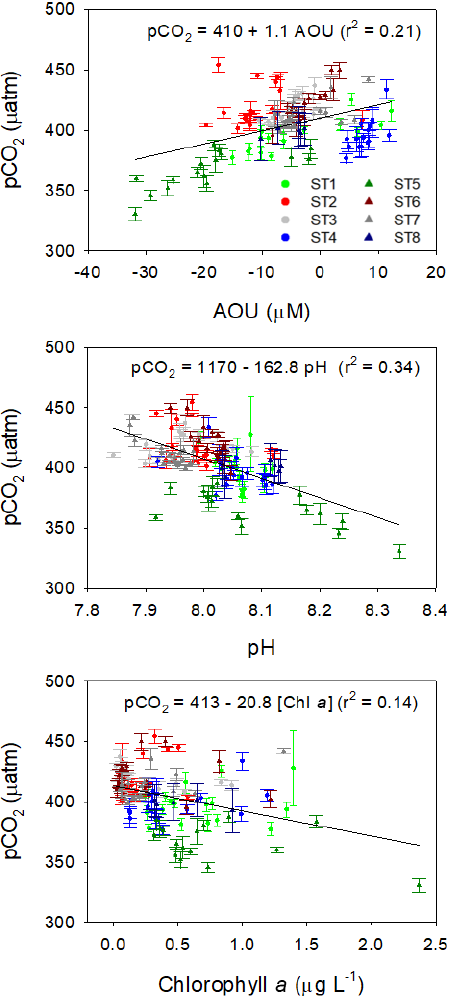
Figure 7. Relationships between the surface values of p CO 2 and apparent oxygen utilization (AOU), pH and chlorophyll a (Chl a ) at the 16 discrete stations during the eight cruises. p CO 2 presents the standard deviation associated with the mean value obtained from the underway